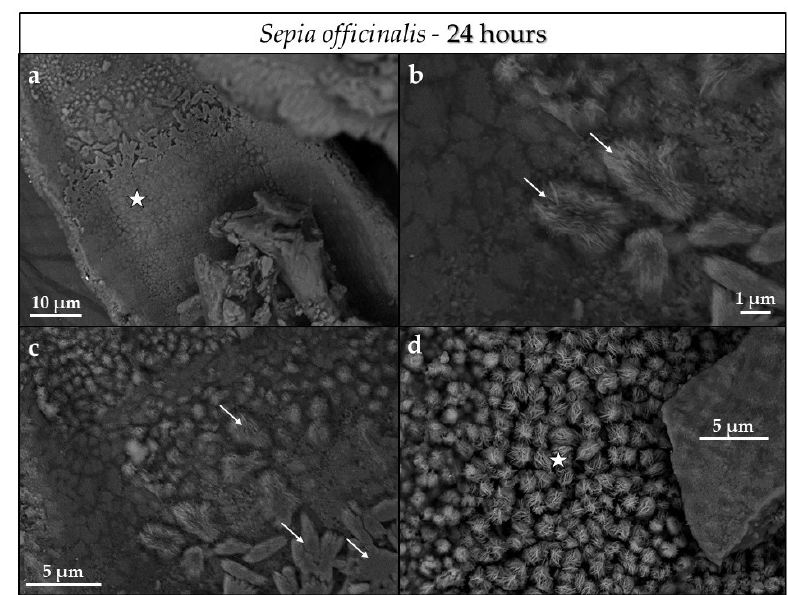
Figure 8. ( a – d ) FE-SEM images of Sepia officinalis cuttlebone after 24 h of conversion. Outer surfaces of skeletal elements (e.g., a chamber ( a )) within the skeleton are covered with AP crystals. These become dense (white star in ( d )), often fuse (white arrows in b , c ) and finally encase the outer surface of the skeletal element (white star in ( a )), conserving its outer morphology.